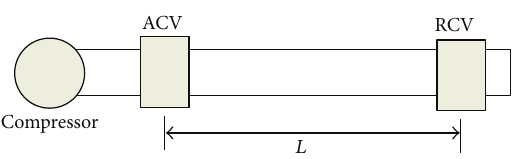
Figure 2: Hydrogen-natural gas mixture installation